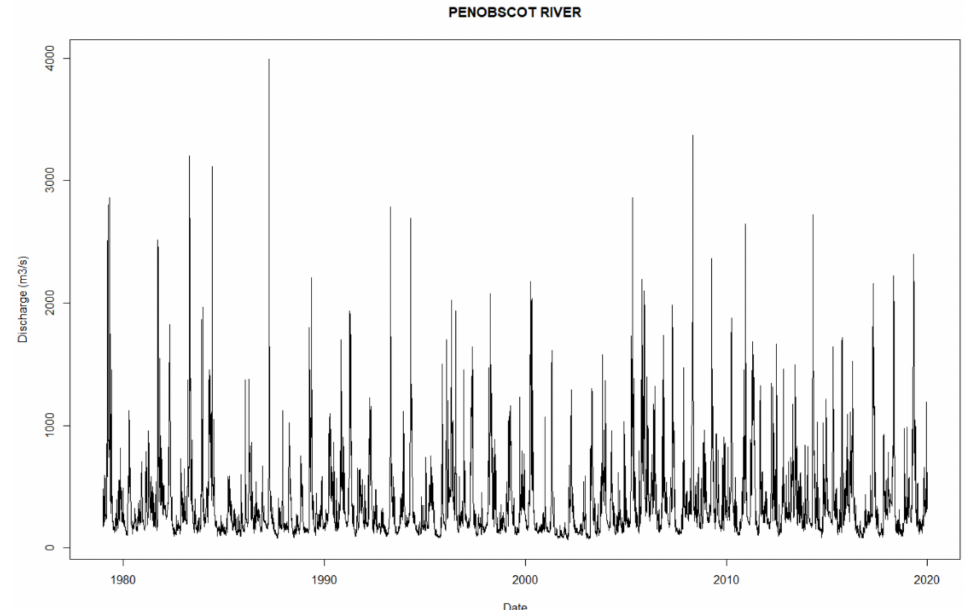
Figure 3. Example of the river discharge time series for one of the investigated catchments for the period 1979–2019. River discharge data were obtained from the GRDC. The Penobscot river is located in the USA and has a catchment area of 17,317 km 2 , and most of the catchment area is located in the Warm Summer Humid Continental climate zone.